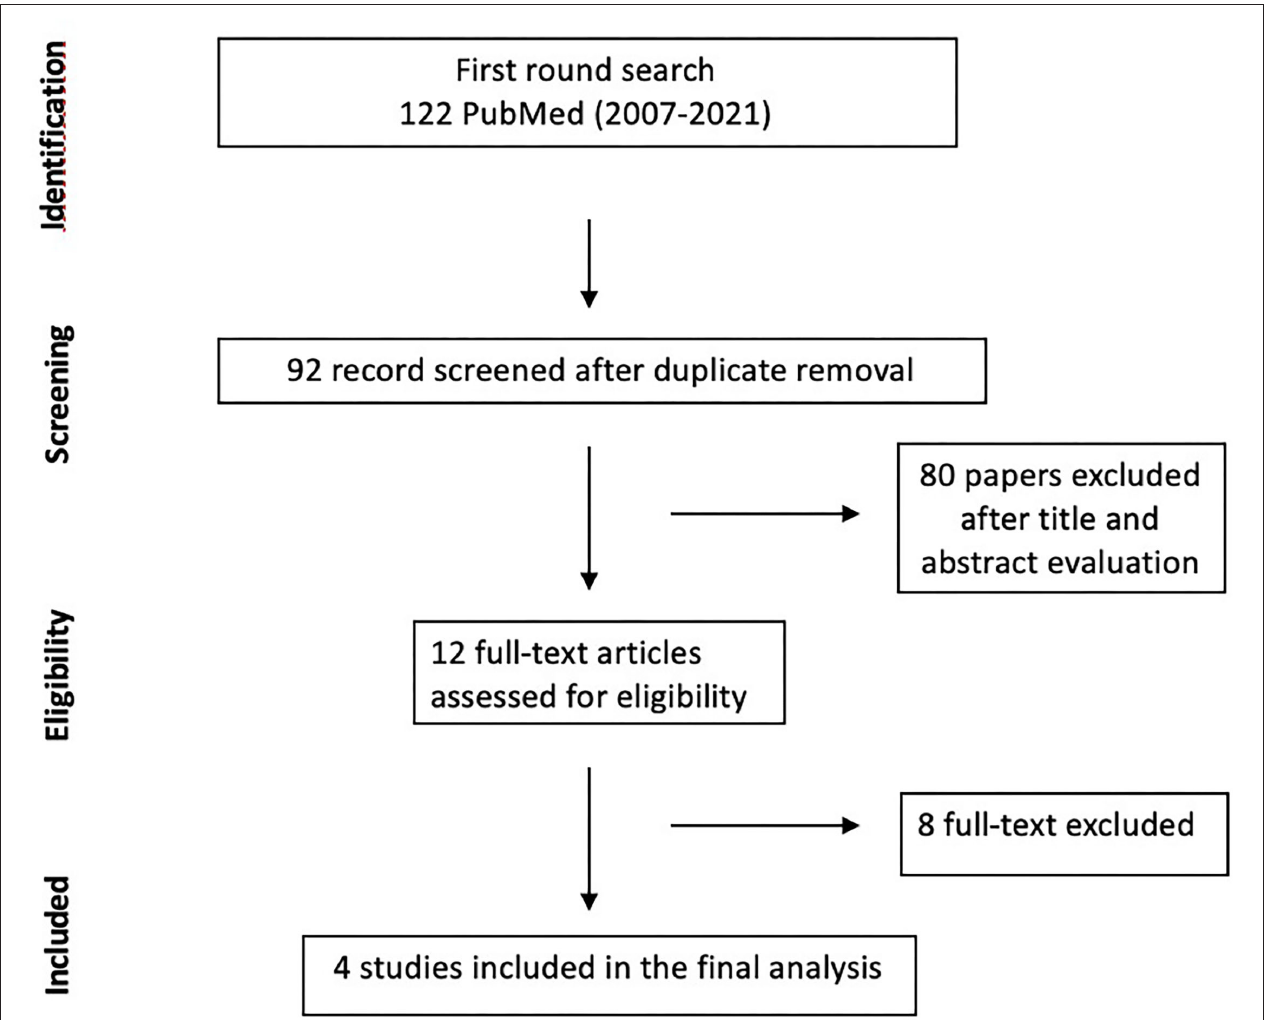
FIGURE 1 | Flow chart of Search strategy divided by identification, screening, eligibility,